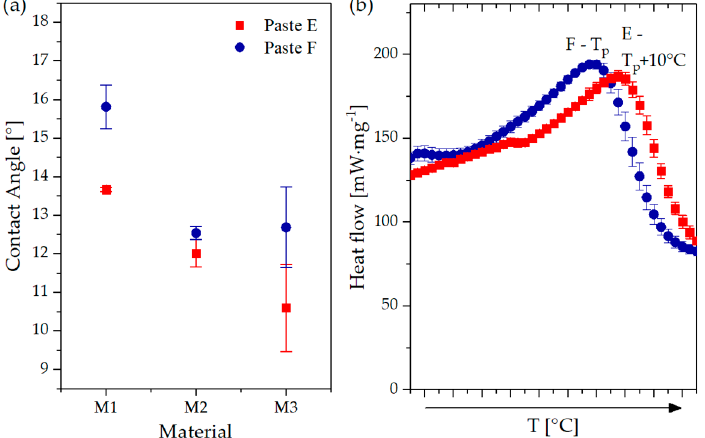
Figure 6. Influence of organic vehicles of pastes E and F on laser power threshold: ( a ) contact angle of organic vehicle of pastes E and F on different film materials, ( b ) heat flow vs. temperature for pastes E and F.